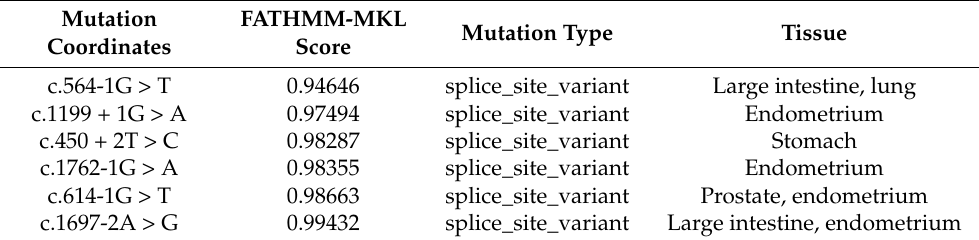
Table 3. Likely pathogenic non-coding PRMT5